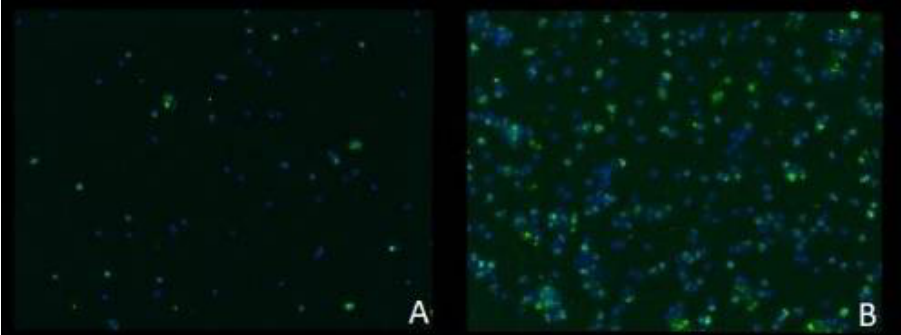
Figure 8. Staining of DNA double-strand breaks (green) in lymphocytes (blue) showing an increase in double-strand breaks after higher total dose irradiation: ( A ) group 2; ( B ) group 3.